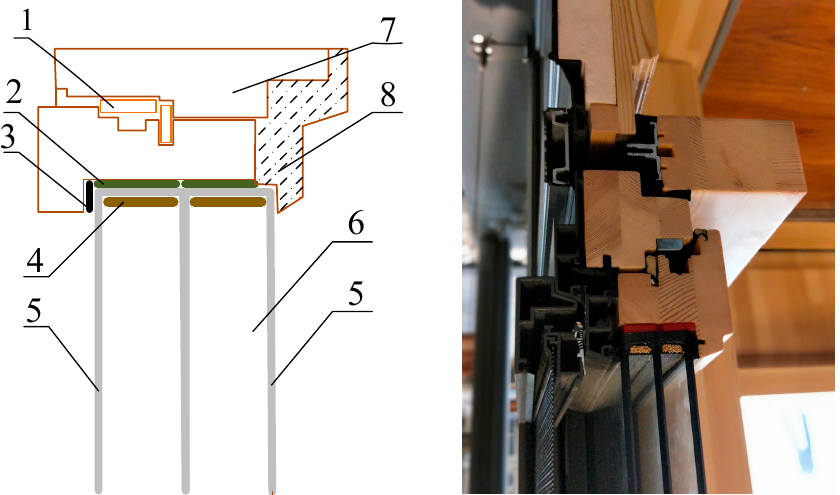
Figure 8. Window profile: (1) polymer connection clasp; (2) warm-edge interval bar; (3) seal layer; (4) dry molecular sieves; (5) tempered glass in 5 mm thickness; (6) argon in a glass cavity of 18 mm thickness; (7) window frame; (8) intensified insulation. The cross-sectional photograph of P120 window enclosure structure is also shown in the right panel.